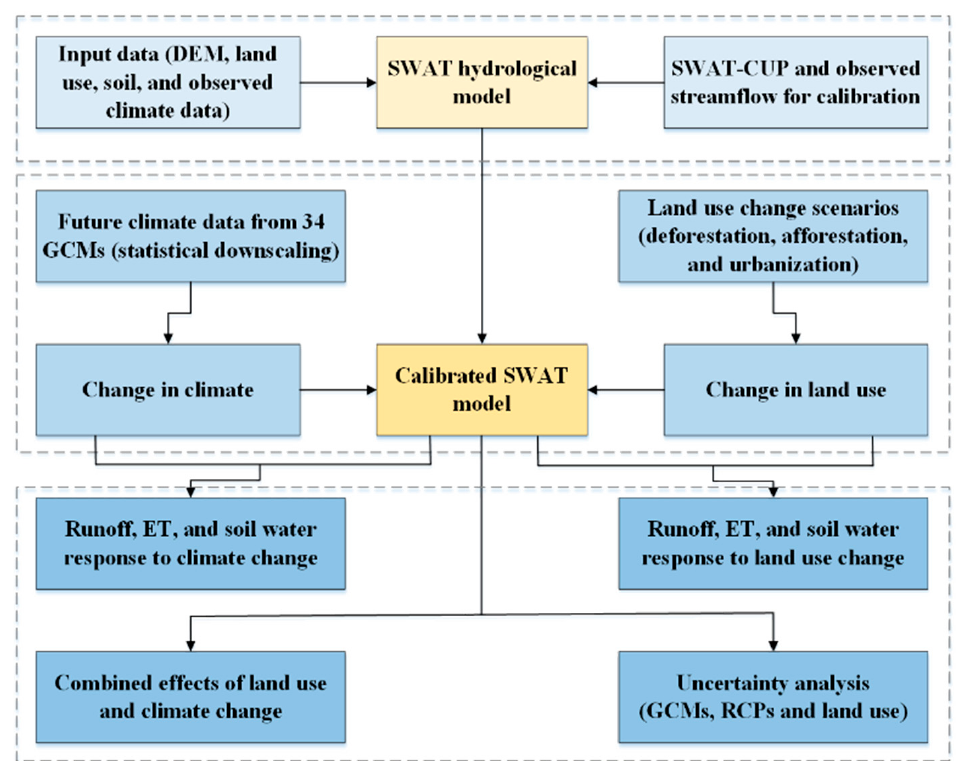
Figure 3. Flow chart of climate hydrological modeling in this study.